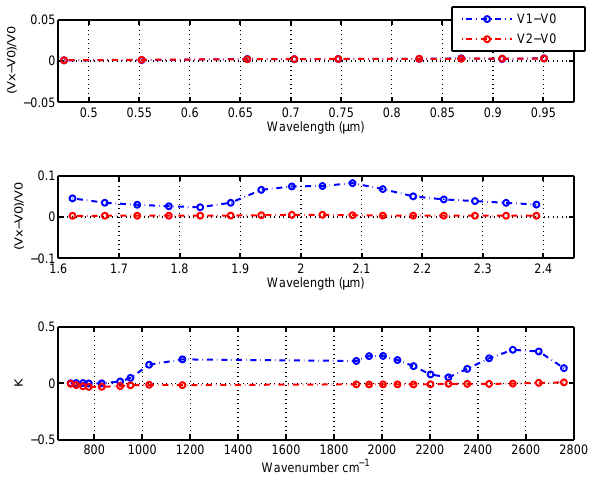
Fig. 20. Same as Fig. 19 but for Sector 2.